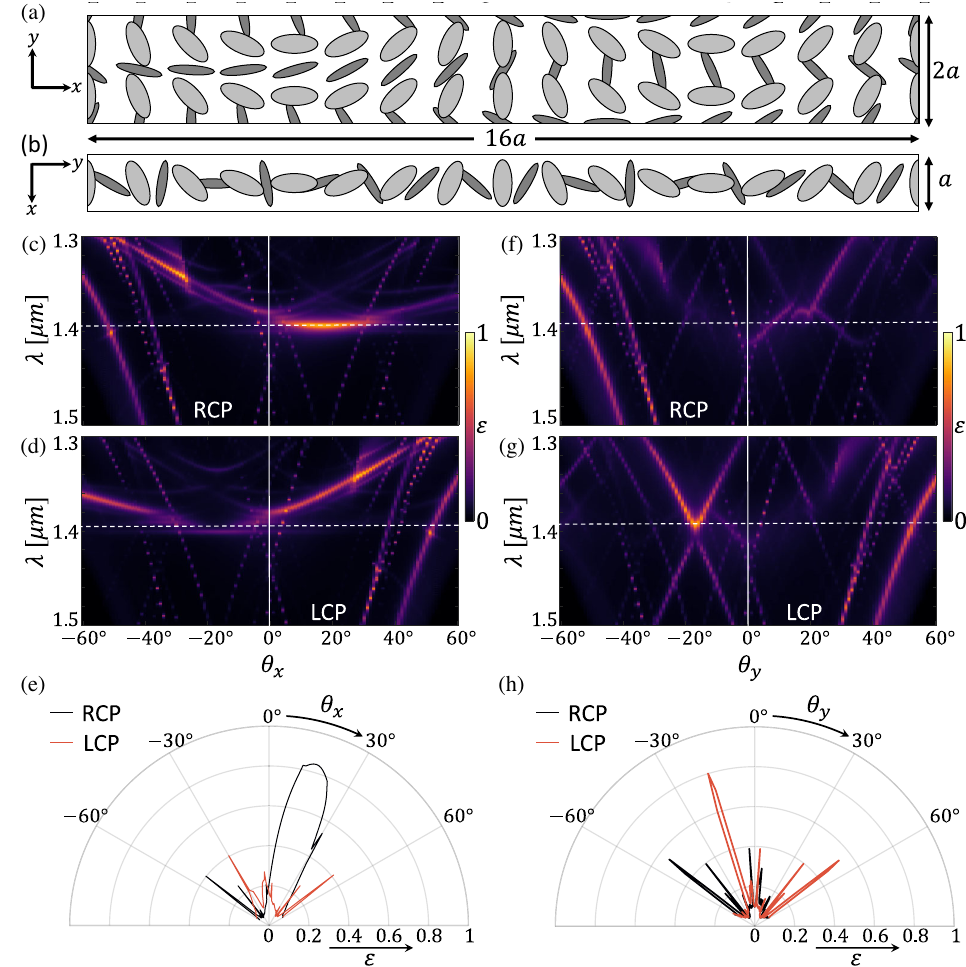
FIG. 7. Selective and directional emission from a thermal metasurface. (a) The superperiod of a thermal metasurface designed to emit RCP light at non-normal incidence, with low spatial coherence. (b) A superperiod designed to emit LCP light at non-normal incidence, with high spatial coherence. (c),(d) RCP and LCP emission maps for the device in (a) as a function of the wavelength and altitude in the x direction, θ . (e) Emission patterns for the device in (a) at the wavelength of the quasi-BIC ’ s band edge [dashed contours in (c) and (d)]. x The band is flat near the band edge, meaning the spatial coherence is low and the emitted lobe is broad. (f),(g) RCP and LCP emission maps for the device in (b) as a function of wavelength and altitude in the y direction, θ . (h) Emission patterns for the device in (b) at the y wavelength of the quasi-BIC ’ s band edge [dashed contours in (f) and (g)]. The band is not flat near the band edge, meaning the spatial coherence is high and the emitted lobe is